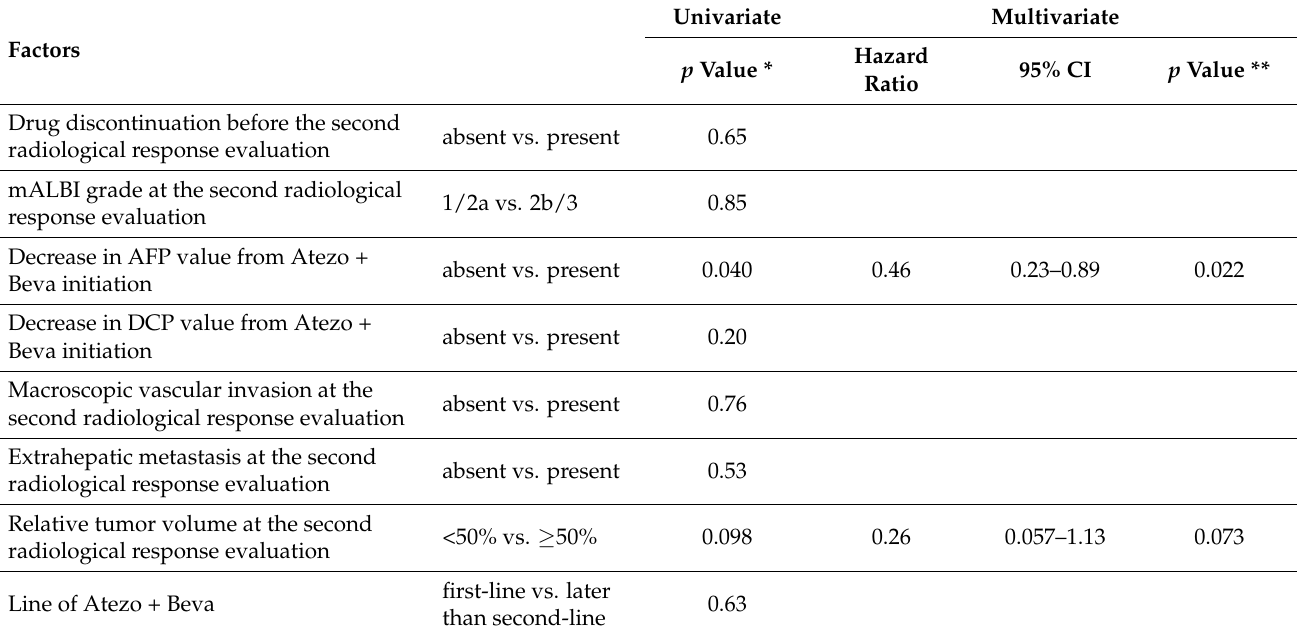
Table 6. Univariate and multivariate analyses of prognostic factors for progression-free survival from atezolizumab plus bevacizumab combination therapy initiation in 59 patients with SD at the second radiological response evaluation by Response Evaluation Criteria in Solid